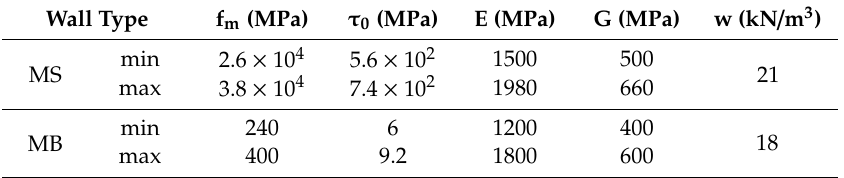
Table 2. Range of values of the mechanic parameters related to the walls identified for the analysis, extracted from Table C8.5.I of the Circ. No 7 / 2019 for masonry in split stone with good texture (MS)